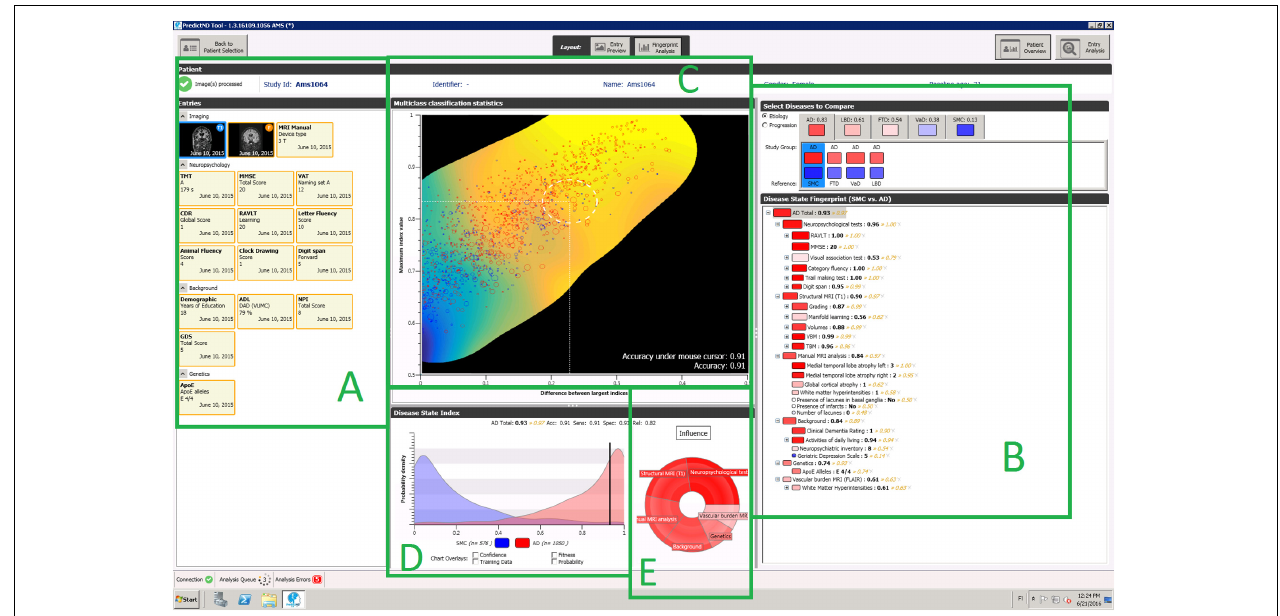
FIGURE 1 | A screenshot of the PredictND tool, a CDSS for differential diagnosis of dementia. The tool contains for example: structured access to the raw data and to visualizations of the MRI analysis (A) , and a visualization of the hierarchical decision making of process of the DSI classifier (B) , visualization of the expected accuracy of the DSI classifier for this patient (C) , distribution of an individual biomarker for different diagnostic groups (D) , and visualization of relative influence of different measurement modalities to the DSI classifiers classification (E)